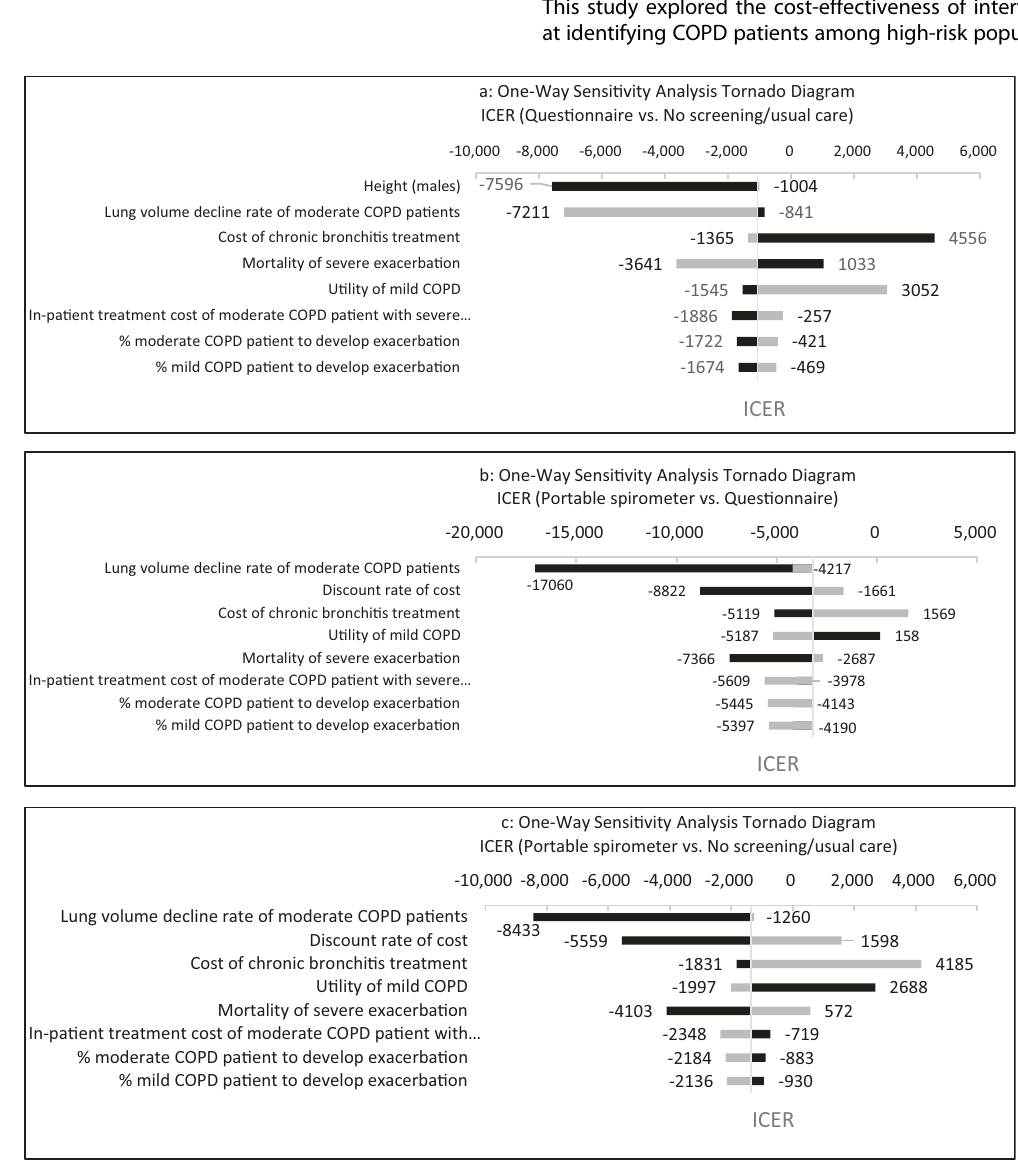
QALY Quality-adjusted life years; ICER Incremental cost-effectiveness ratio.